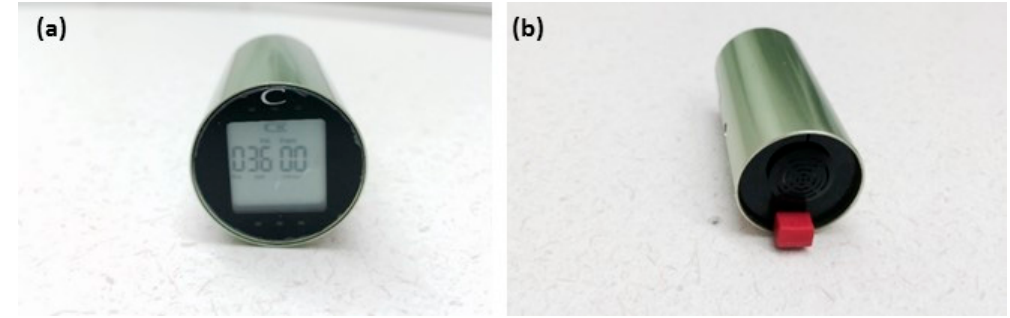
Figure 1. CairClip sensor front ( a ) and rear ( b ) views.